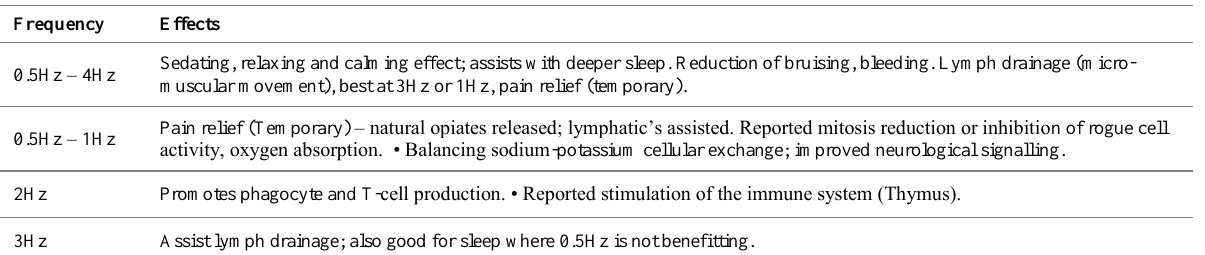
Table 3. The effect of Magnafield® at some specific